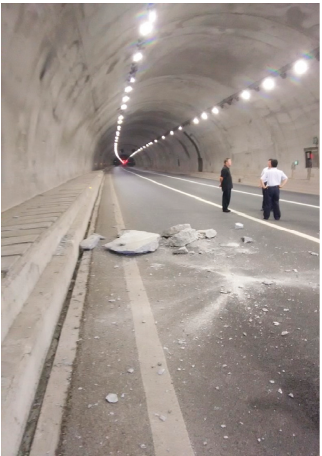
Figure 3: Crack of LK35 +220 (July 4